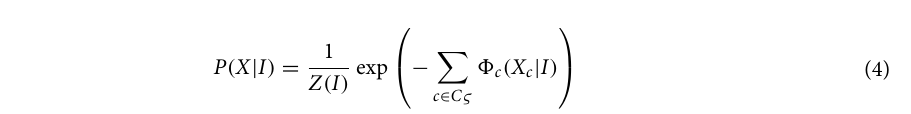
Figure 5. Principle for coarse segmentation of macular edema in OCT image. ( A ) Operating principle of residual learning block. ( B ) The workflow of conventional convolution and atrous convolution. Conventional convolution operation with 3 × 3 kernel size and 1 stride. Atrous convolution operation with 3 × 3 kernel size, 1 stride, and 2 rate. ( C ) Coarse segmentation of macular edema in OCT